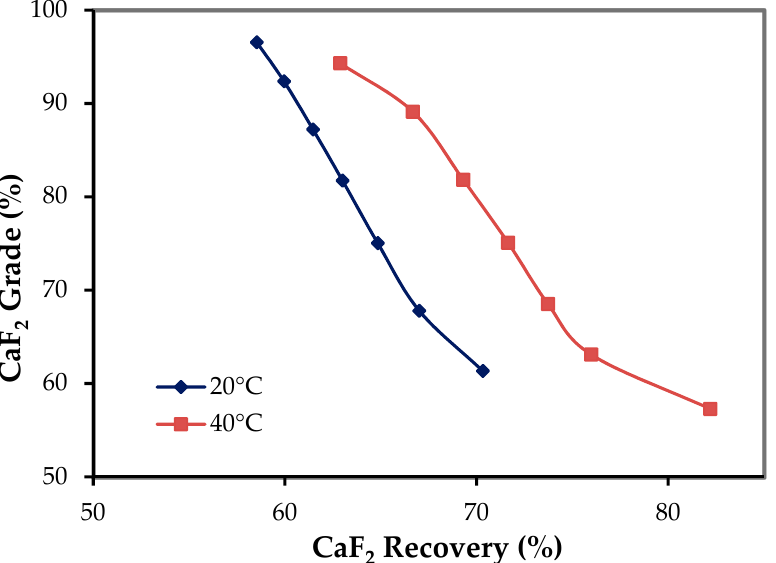
Figure 4. E ff ect of pulp temperature on the grade–recovery relationship for ore Figure 4. Effect of pulp temperature on the grade–recovery relationship for ore A.